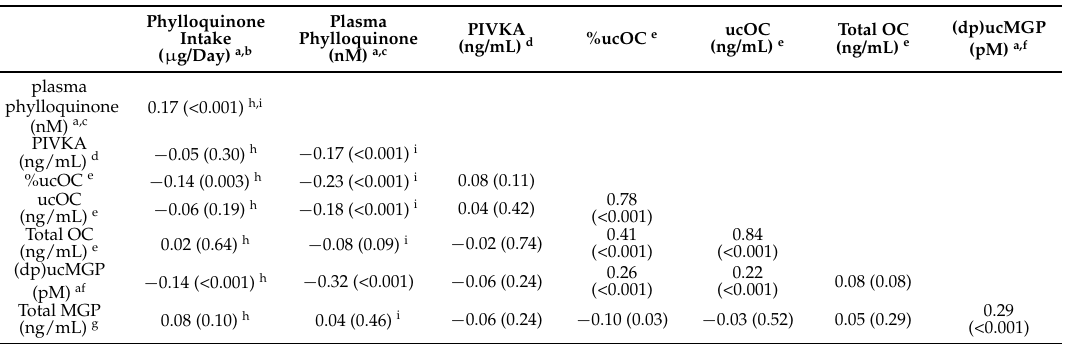
Correlations among phylloquinone intake and biomarkers of vitamin K status in community-dwelling primarily Caucasian older adults ( n = 443). Data are presented as Pearson correlation coefficients ( p